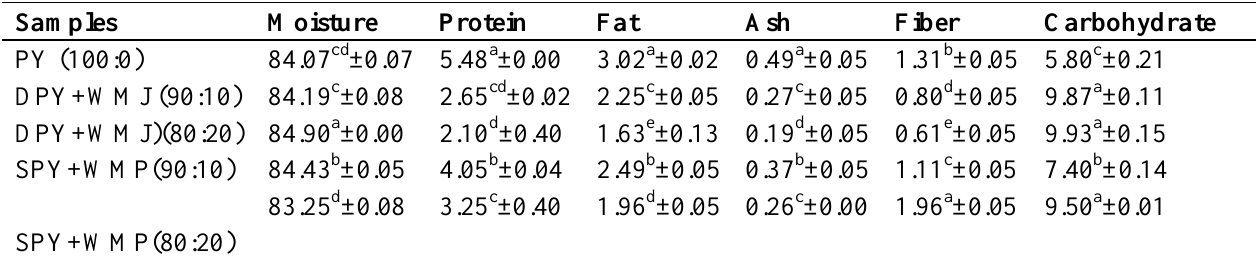
Table 3: Proximate Composition of Spoonable and Drinkable Yoghurt Blended with Graded levels of Watermelon Pulp and